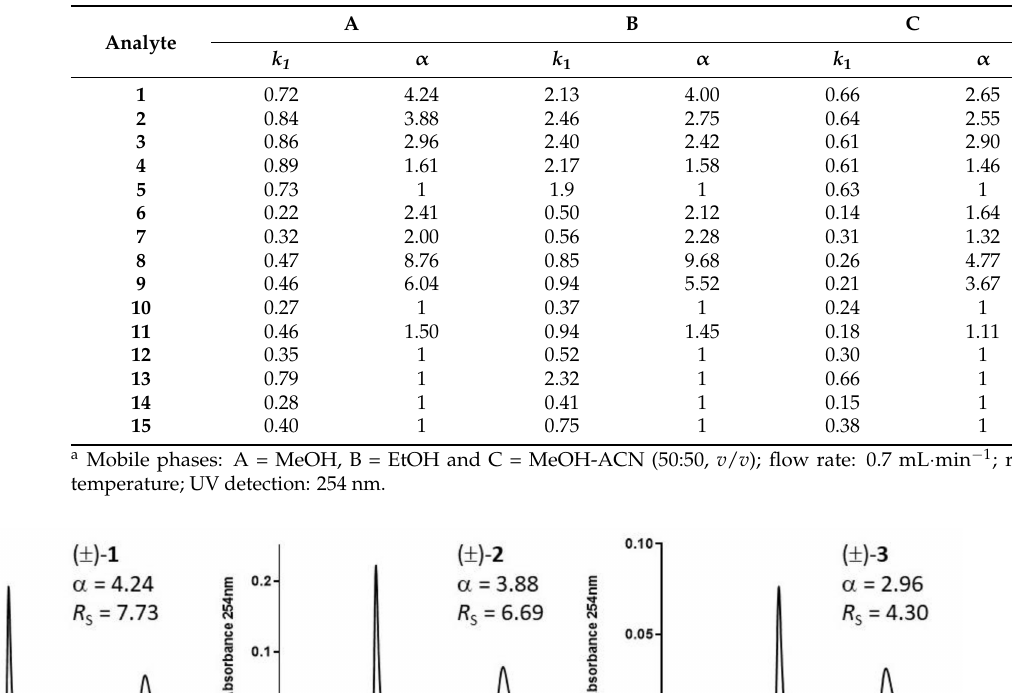
Table 2. Chromatographic data: retention factors of the first eluted enantiomer ( k 1 ) and separation factor ( α ), for the chiral DHP analytes on a Chirobiotic TM TAG column with three organic polar mobile phases a . Analyte